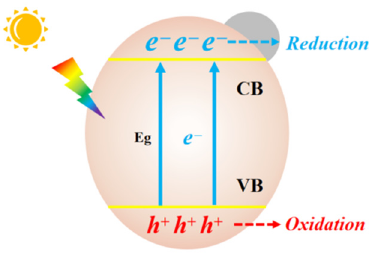
Figure 1. Fundamentals of photocatalytic reduction on a semiconductor catalyst.